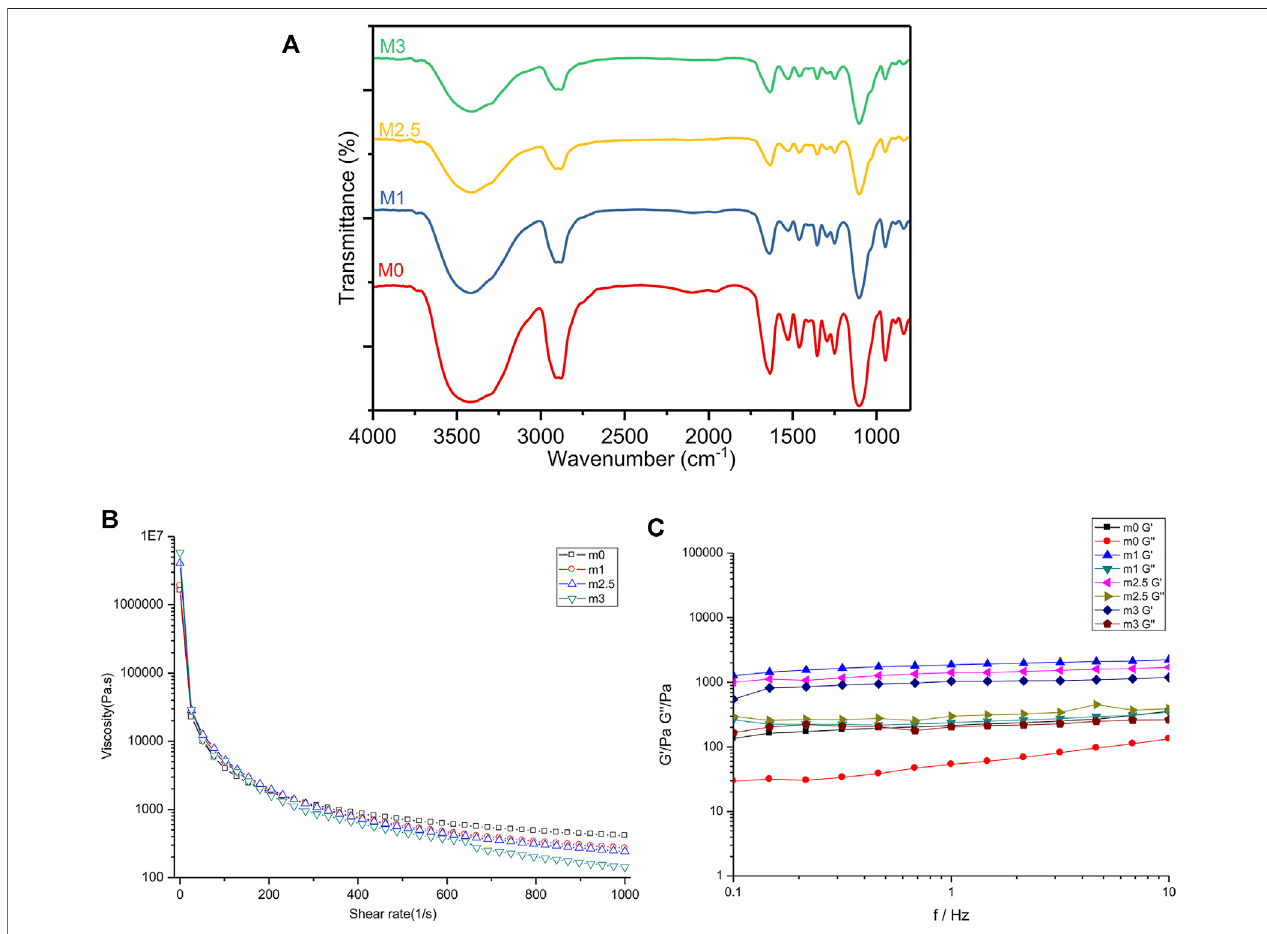
FIGURE 2 | Mechanical characteristics of m0, m1, m2.5, and m3 hydrogels. (A) FT-IR spectra of four fi lms after lyophilization. (B,C) rheological analyses of four hydrogels before crosslinking with CaCl 2 . (B) fl ow curves of hybrid bioinks with a shear rate from 0.1% to 100%. (C) G ′ and G ″ of four hydrogels under the mode of frequency sweep ranging from 0.1 to 10